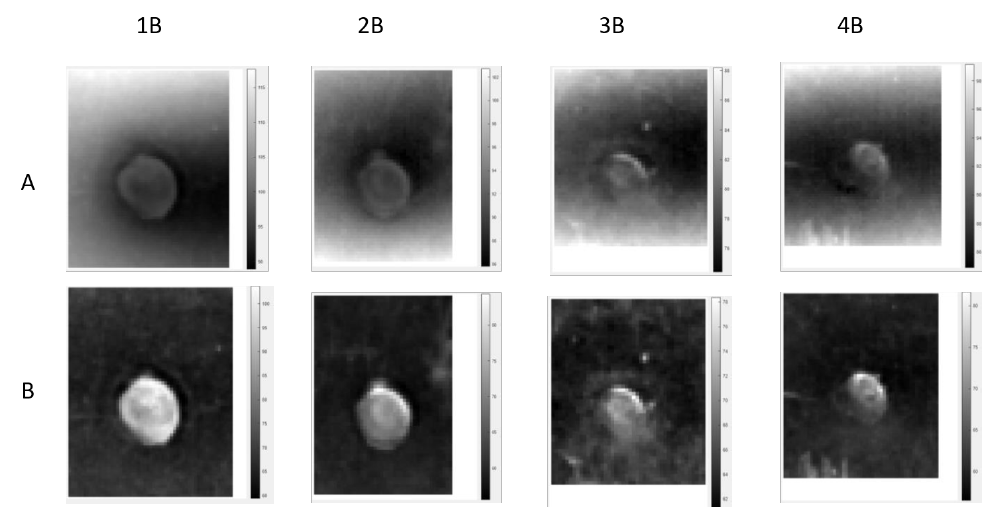
Figure 10. Results from the FFT processing of the thermal data captured using induction heating from the front side of the B-series samples. Row ( A ) shows the phase images of the measurements using an excitation duration of 19 s, and row ( B ) visualizes the amplitude images.